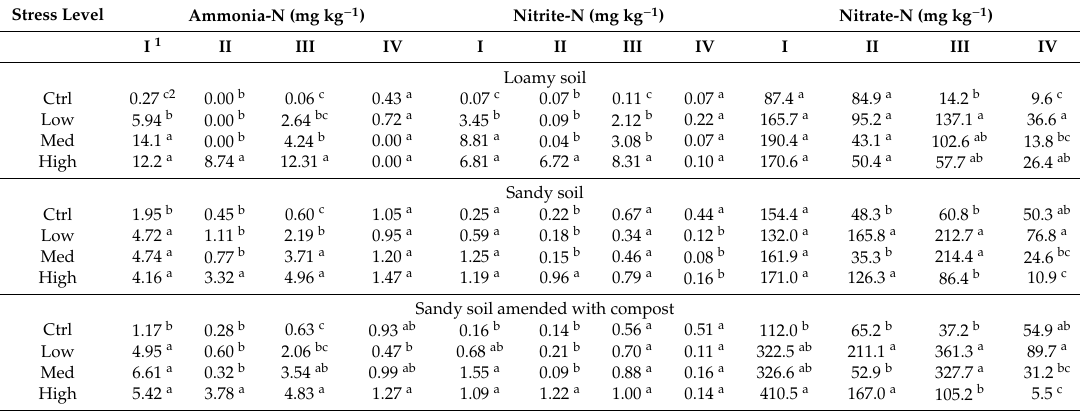
Table 1. Mineral nitrogen forms as dependent on water stress and sampling time.